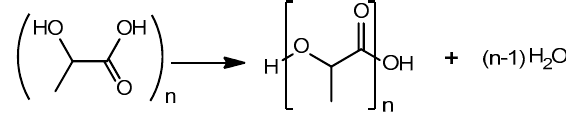
Figure 2. Scheme of autocatalytic lactic acid oligomerization. Molecules 2018 , 23 , x FOR PEER REVIEW